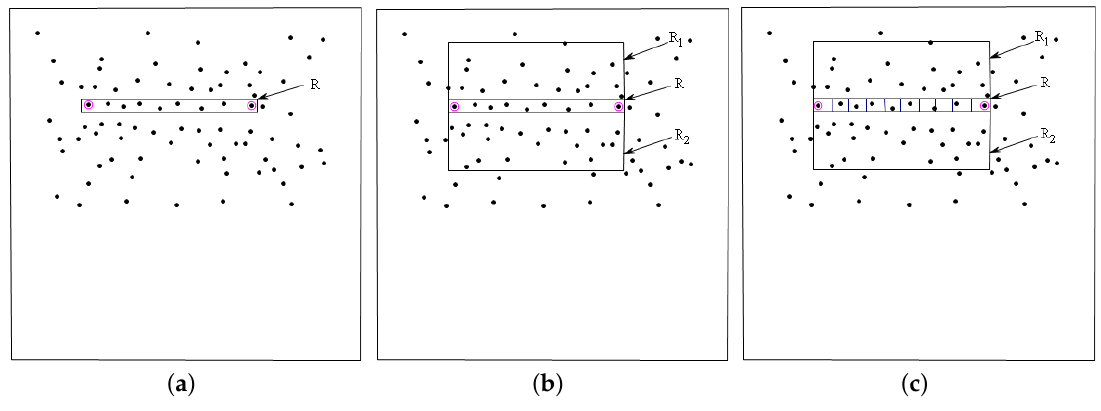
Figure 5. ( a ) a schematic representation of rectangle R ; ( b ) a local rectangle window covered R with three parts; and ( c ) the rectangle R divided into C